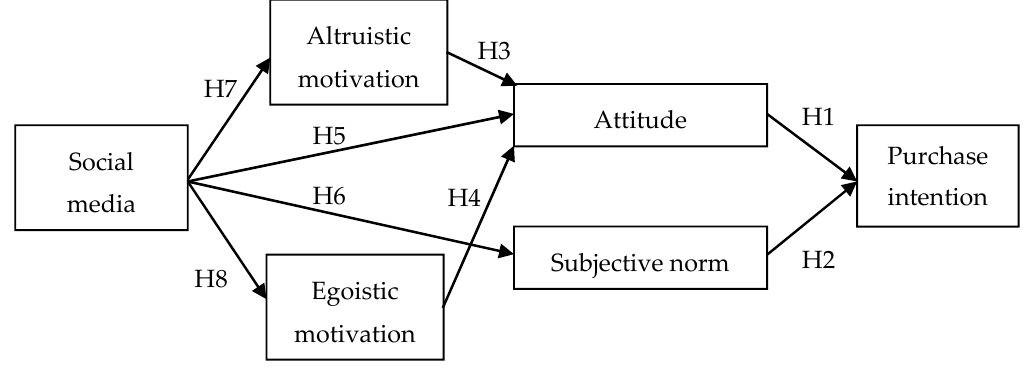
Figure 1. Conceptual model.